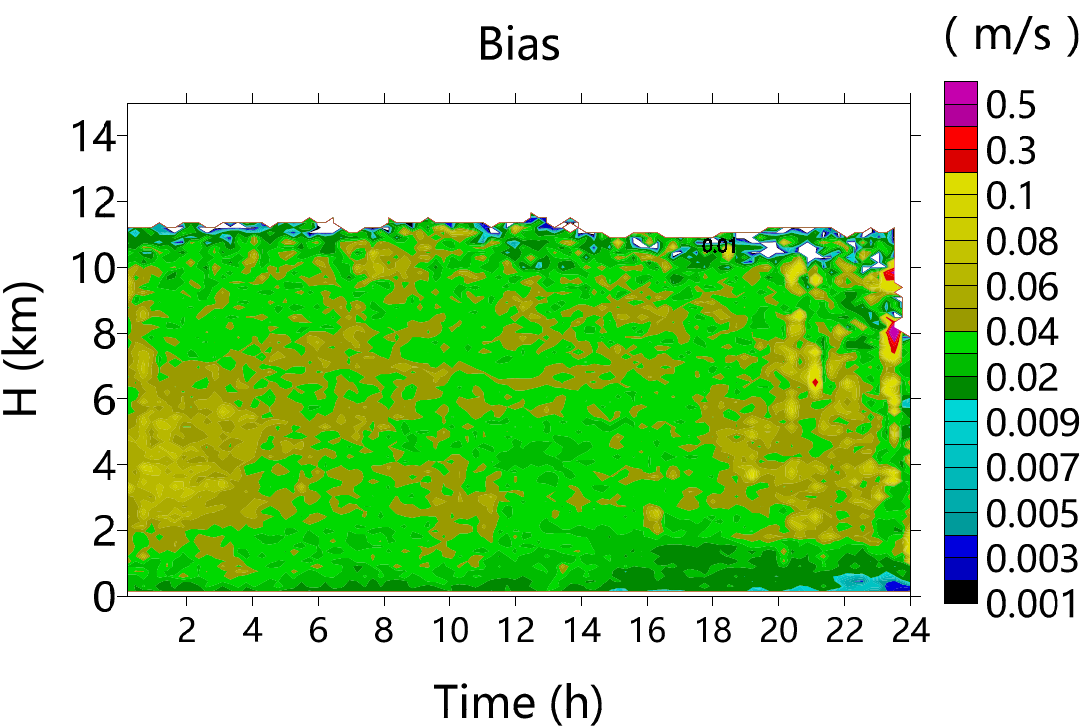
Figure 14. Averaged vertical air motion biases introduced by turbulence, air horizontal wind speed, and the radar beam width.